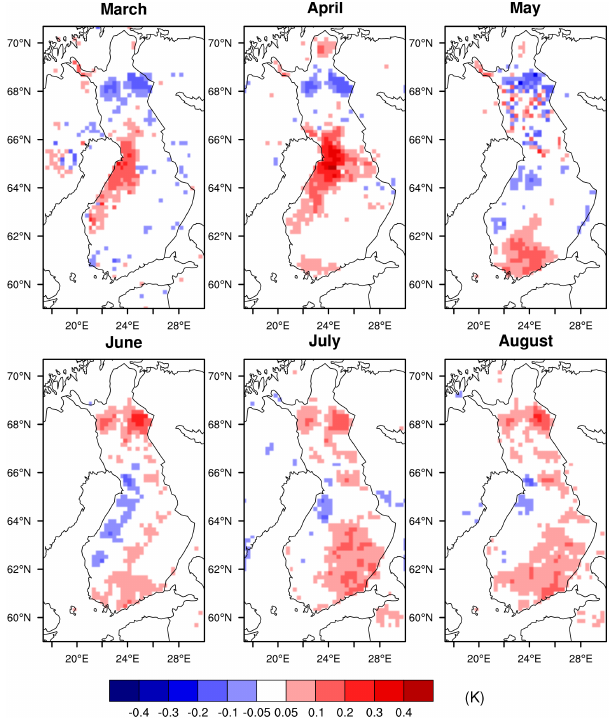
Figure 3. The 15-year averaged differences (FNFI10–FNFI1) in monthly-averaged daily mean 2m air temperature in spring and summer months.